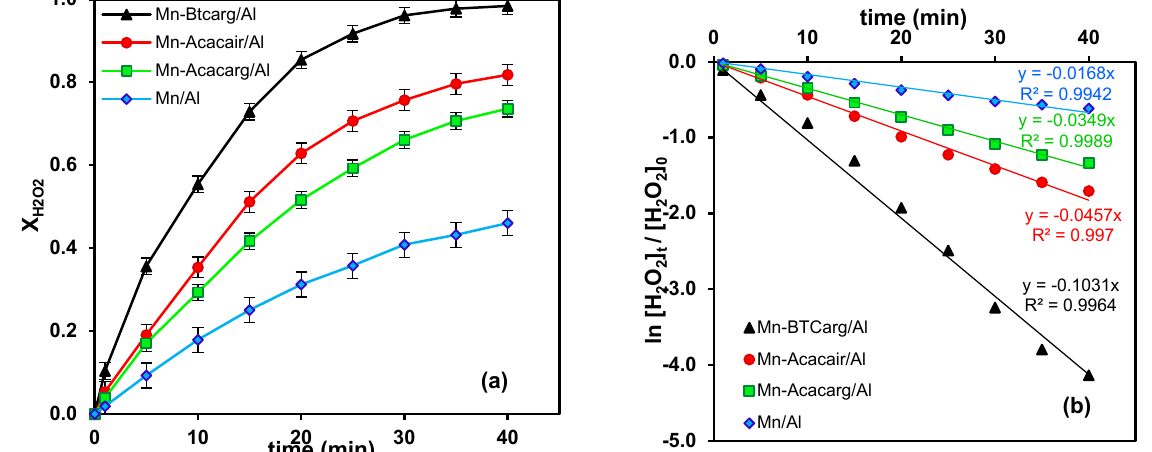
Figure 6. Conversion of hydrogen peroxide versus time for different used catalysts ( a ) and the kinetic plots ( b ); catalyst dosage of 5 g/L and initial H 2 O 2 concentration of 10 g/L.